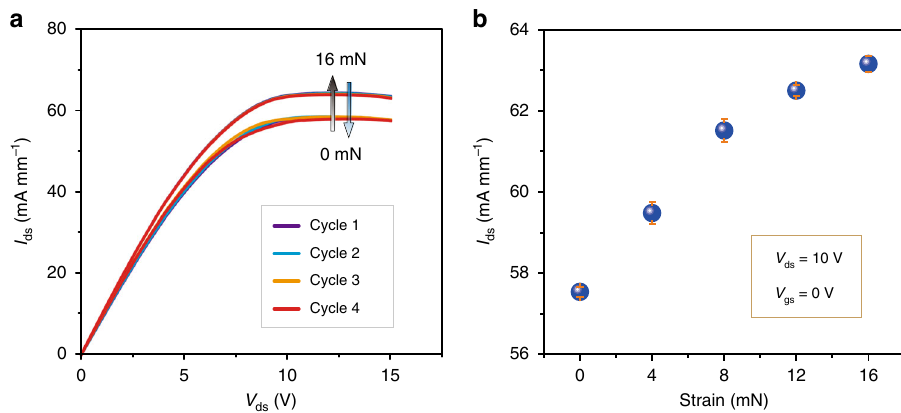
Fig. 5 Reproducible strain-dependent analysis of the SPD. a Output ( I ds – V ds ) characteristics of the SPD in four consecutive cycles as the load and release of strain (0/16 mN). b Statistical variation of the SPD. The data are measured at V ds = 10 V, V gs = 0 V under external strain of 0 – 16 mN. Error bars indicate standard deviations for four sets of data